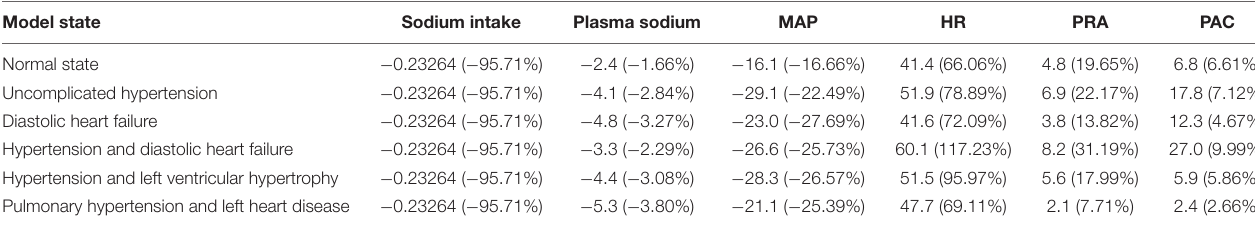
TABLE 3 | Exact and relative difference in sodium intake (mEq/min), plasma sodium (mEq/l), mean arterial pressure (MAP, mmHg), heart rate (HR, beats/min), plasma renin activity (PRA, fmol/ml/min) and plasma aldosterone concentration (PAC, pg/ml) between high (day 6) and low (day 11) salt diets. Model